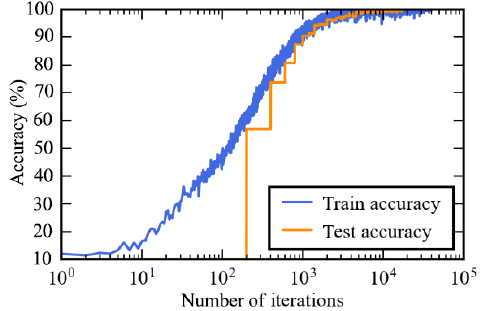
Fig. 9 Train and test accuracy with 2000 samples in Case 1.